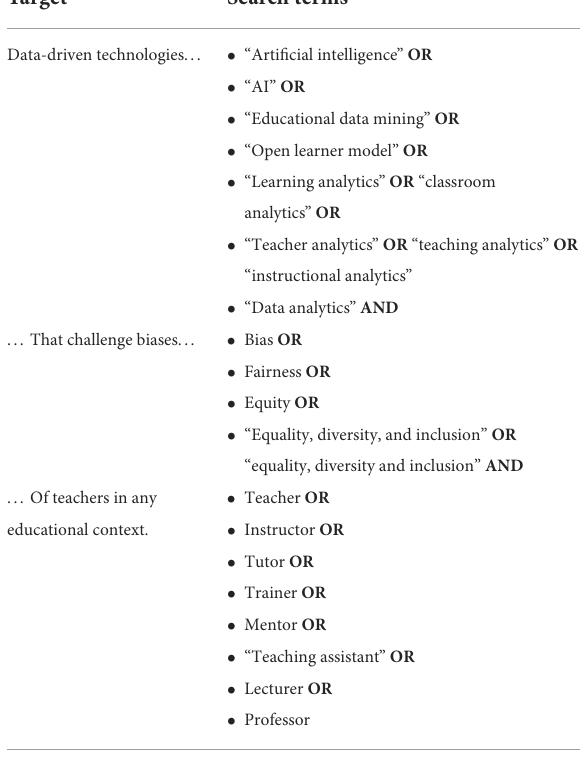
TABLE 1 General search string